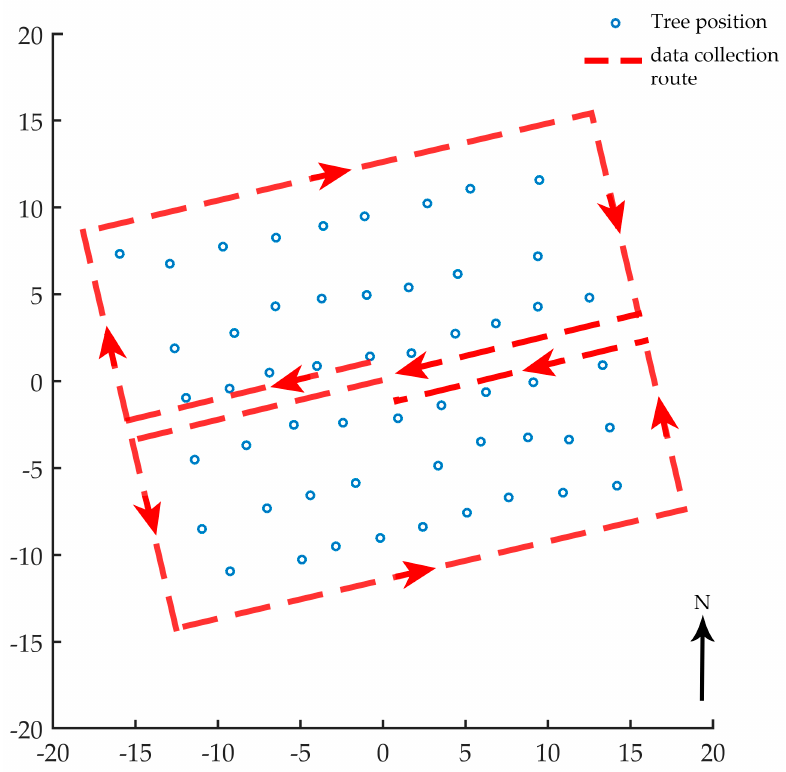
Figure 2. The data collection route using personal laser scanning (PLS).